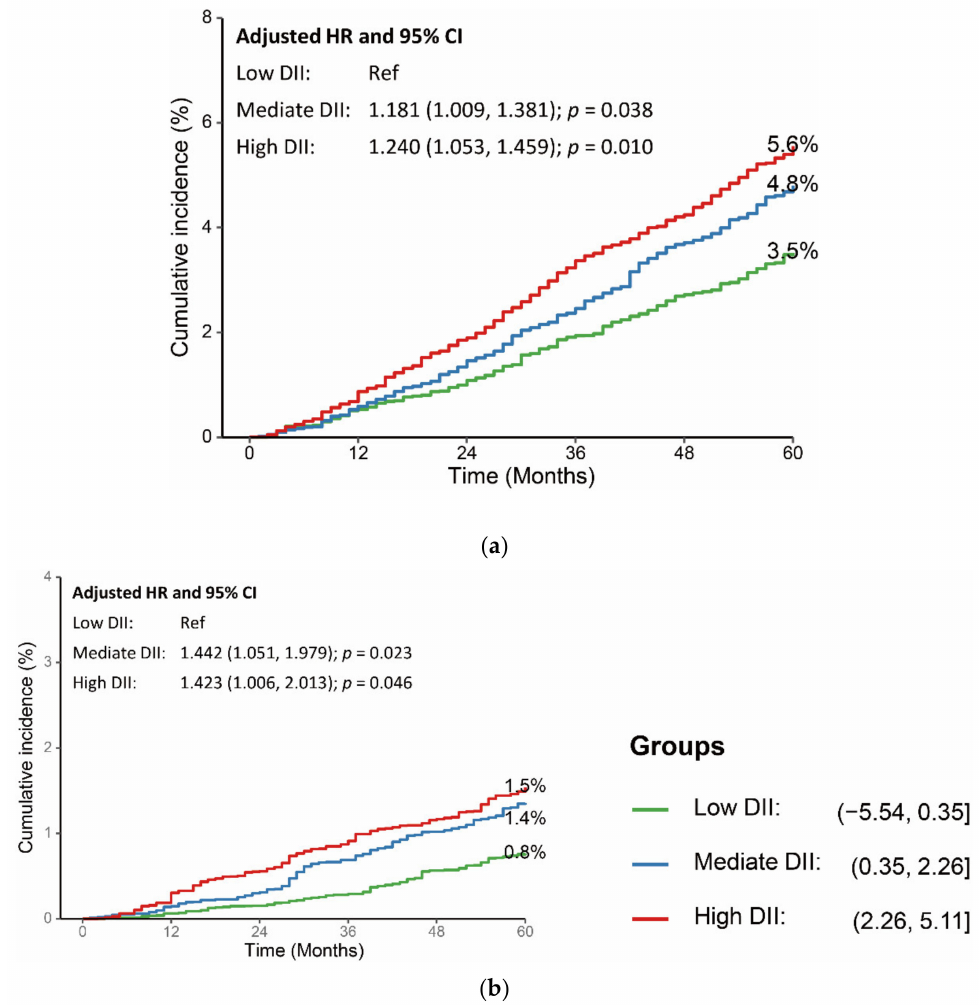
Figure 4. Association between DII scores and long-term ( a ) all-cause mortality and ( b ) cardiovascular mortality. HR was adjusted for age, sex, educational level, BMI, smoke, hypertension, hyperlipidemia, glycemic status, recreational activity, and alcohol consumption. CI: confidence interval; DII: dietary inflammatory index; HR: hazard ratio; and Ref: